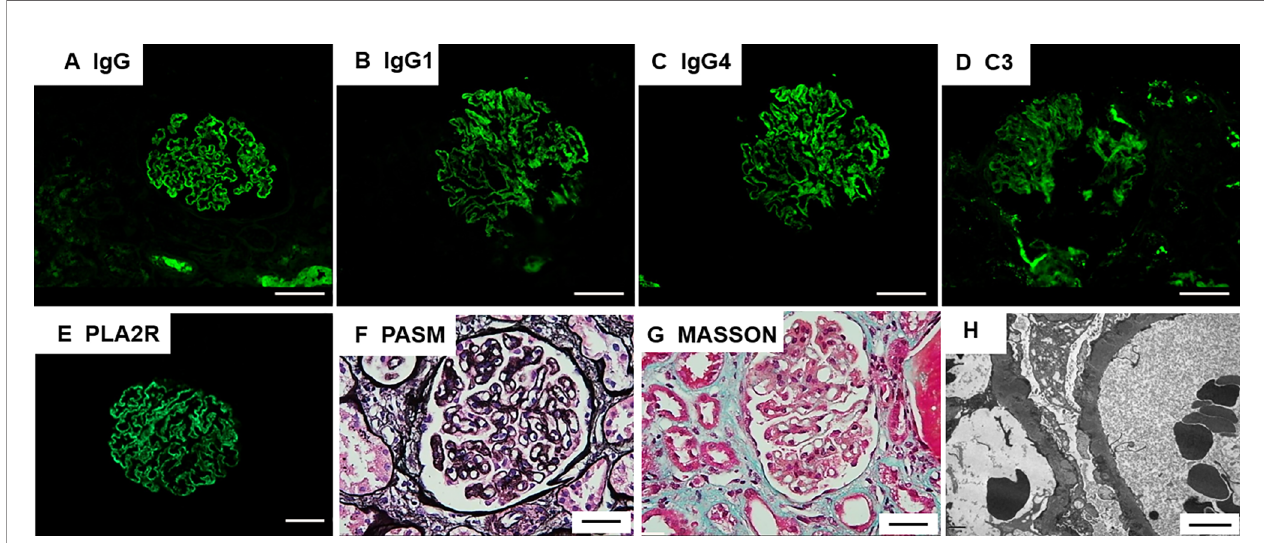
FIGURE 2 | Renal pathology fi ndings. (A) Immuno fl uorescence microscopy demonstrates granular deposits of IgG along the glomerular basement membrane; Scale bar = 20µm (B, C) IgG1 and IgG4 deposits detected by IgG subclass staining; Scale bar = 20µm (D) C3 deposits shown by immunohistochemical staining; Scale bar = 20µm (E) Immunostaining for phospholipase A2 receptor (PLA2R) is positive; Scale bar = 20µm (F) Periodic acid-methenamine silver (PAM) staining of the patient ’ s glomeruli reveals a spiked appearance of the glomerular basement membrane; Scale bar = 20µm (G) Masson ’ s trichrome staining revealed fuchsinophilic protein deposits beneath the visceral layer; Scale bar = 20µm (H) Non-uniform diffuse thickening of the glomerular basement membrane, diffuse foot process effacement, and abundant electron-dense deposits beneath the epithelium and within the basement membrane, with a portion of the electron-dense matter embedded and absorbed in the basement membrane. Scale bar =